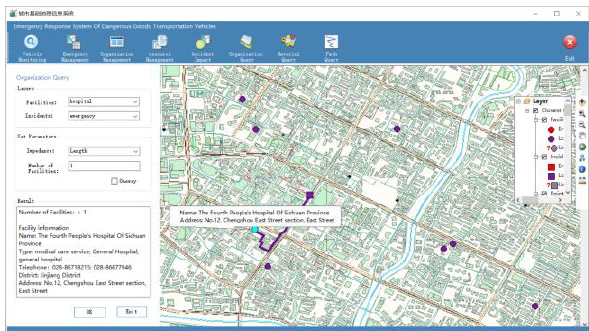
Figure 6. Rescue organization allocation